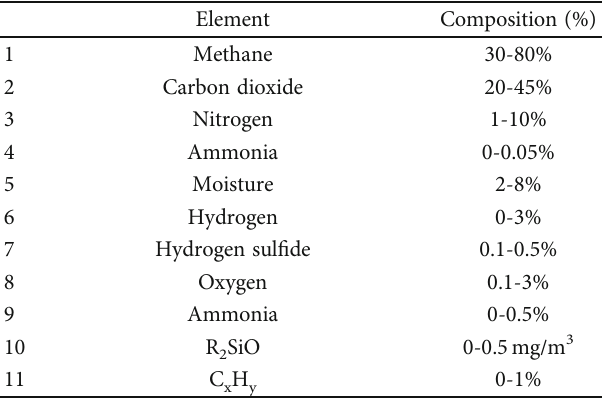
Table 5: Average composition of biogas [16, 33, 40, 56, 114].